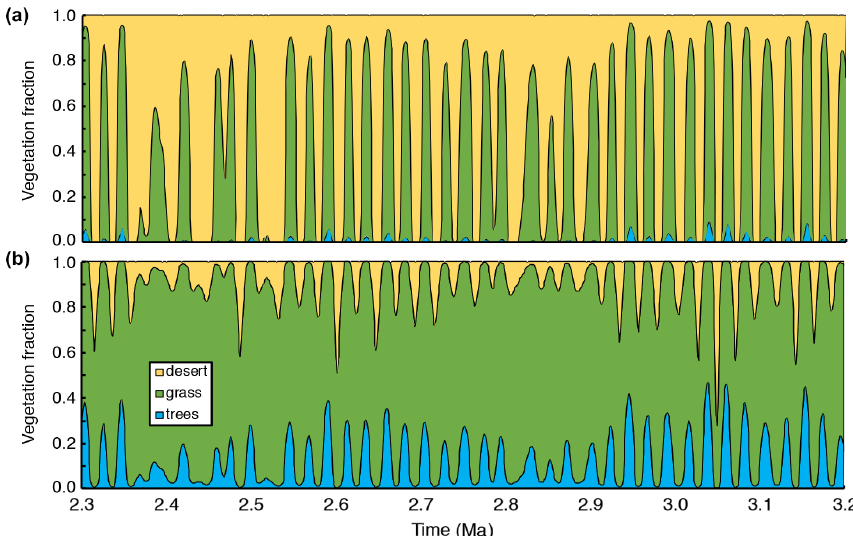
Figure 3. OIG vegetation fractions over (a) grid box 12 (Sahara) and (b) grid box 11 (Sahel). The fraction of desert is given in yellow; grass is green and trees are blue.